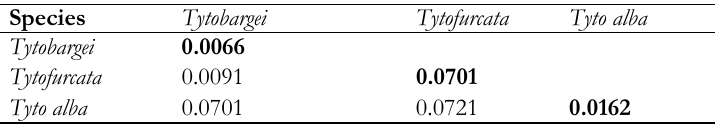
T ABLE 2- Kimura-2-parameter genetic distance interspecies and intraspecies (Bold numbers) in mitochondrial CYTB gene for species of Tyto.